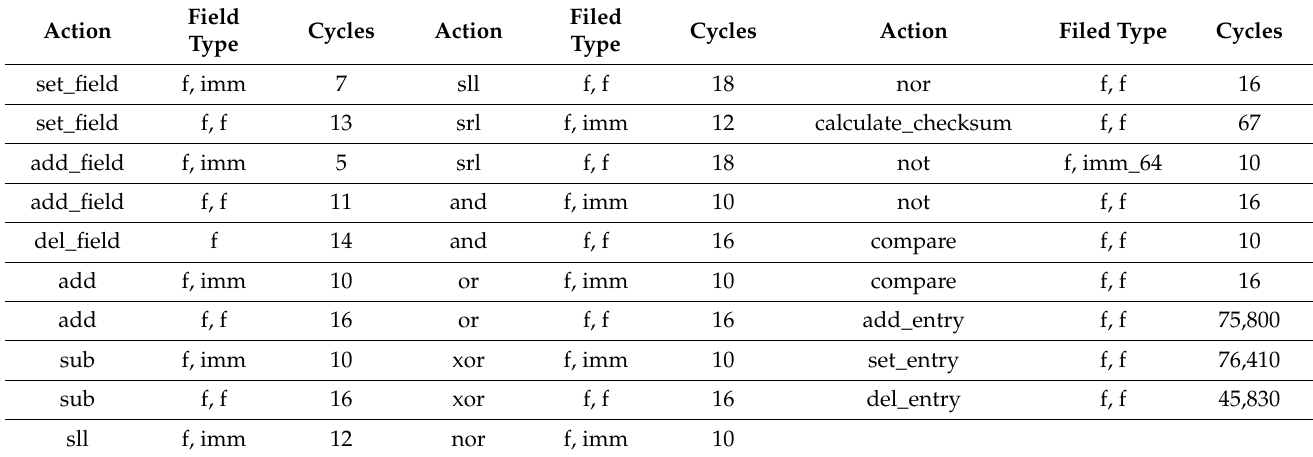
Table 6. Instruction performance compatible with multiple data types.